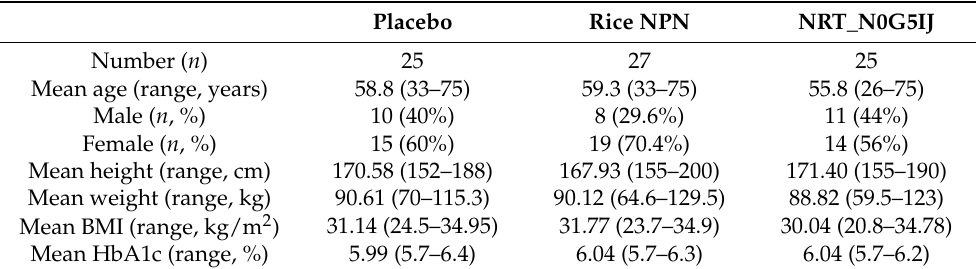
Table 1. Subject demographic for trial